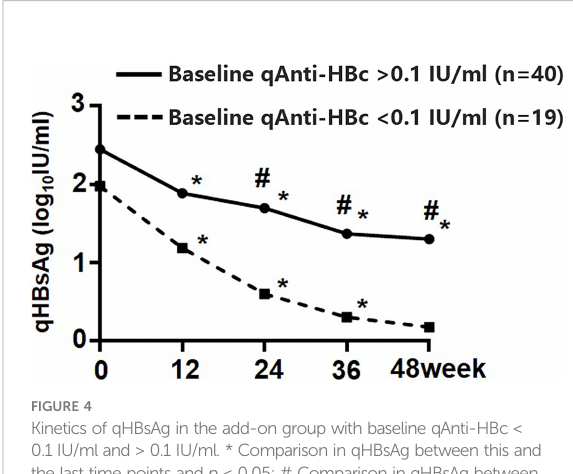
FIGURE 4 Kinetics of qHBsAg in the add-on group with baseline qAnti-HBc < 0.1 IU/ml and > 0.1 IU/ml. * Comparison in qHBsAg between this and the last time points and p < 0.05; # Comparison in qHBsAg between